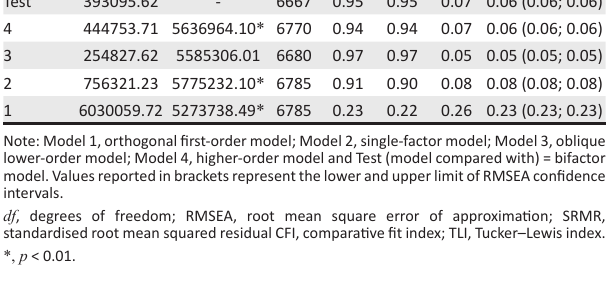
TABLE 2: Fit statistics of different EQ-i 2.0 factor models.